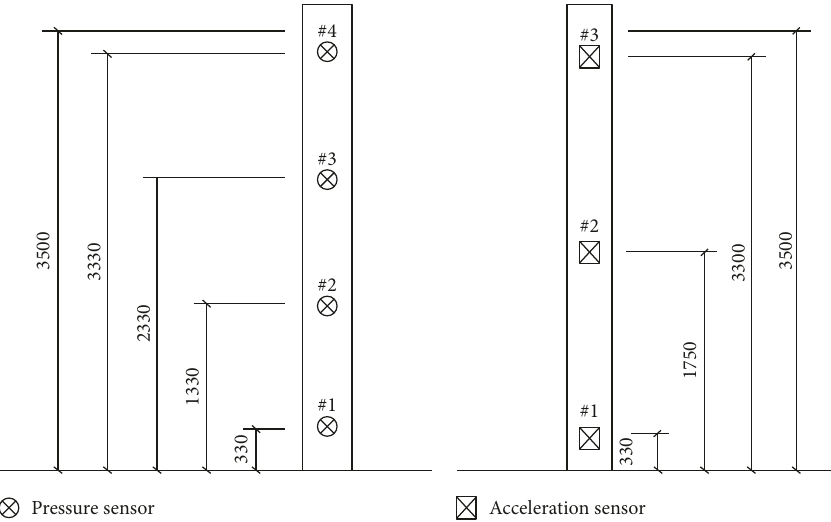
Figure 9: Sensor arrangements of specimen JS5. (a) Pressure sensor. (b) Acceleration